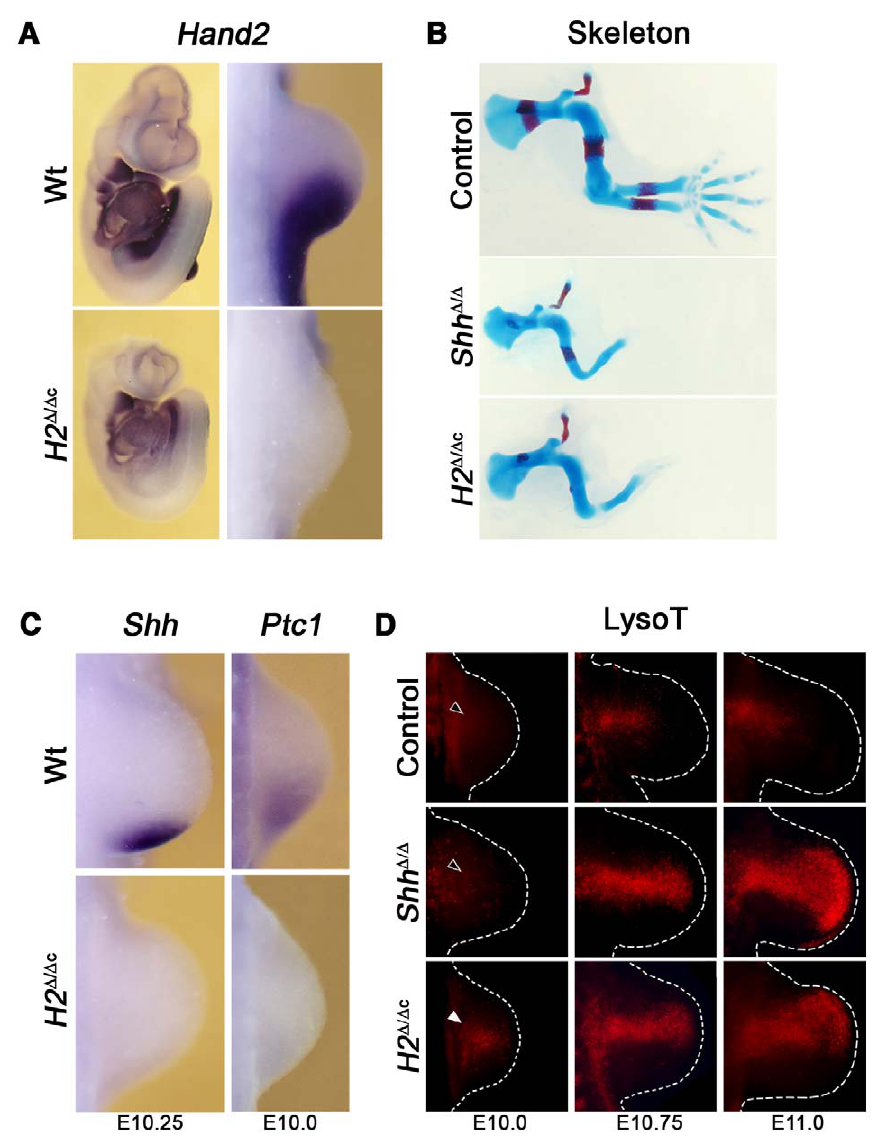
Figure 1. Early deletion of Hand2 in mouse forelimb buds phenocopies the Shh loss-of-function skeletal phenotype. (A) Whole mount in situ hybridization detects Hand2 transcripts in wild-type (Wt) and mouse embryos that lack the Hand2 gene in their forelimb bud mesenchyme ( H2 D / D c ) at E9.75 (28 somites). Hand2 transcripts are absent from forelimb buds of H2 D / D c mouse embryos. (B) Skeletons of mouse forelimbs at E14.5, stained with alcian blue (cartilage) and alizarin red (bone). Prx1 -Cre mediated inactivation of Hand2 ( H2 D / D c ) phenocopies the Shh D / D limb skeletal phenotype. Control: Prx1-Cre tg/ + . (C) Shh and Ptc1 transcripts are absent from H2 D / D c limb buds at E10.25 (32 somites for Shh ) and E10.0 (29 somites for Ptc1 ). (D) Detection of apoptotic cells by LysoTracker Red (LysoT). Hand2 deficient limb buds are compared to control ( Prx1-Cre tg/ + and H2 + /f ) and Shh D / D limb buds at E10.0 (30 somites), E10.75 (37 somites), and E11.0. The white arrowhead points to the precocious initiation of cell death in H2 D / D c forelimb buds (compare white to open arrowheads; n=2/4). In all panels, limb buds are oriented with the anterior to the top and the posterior to the bottom.